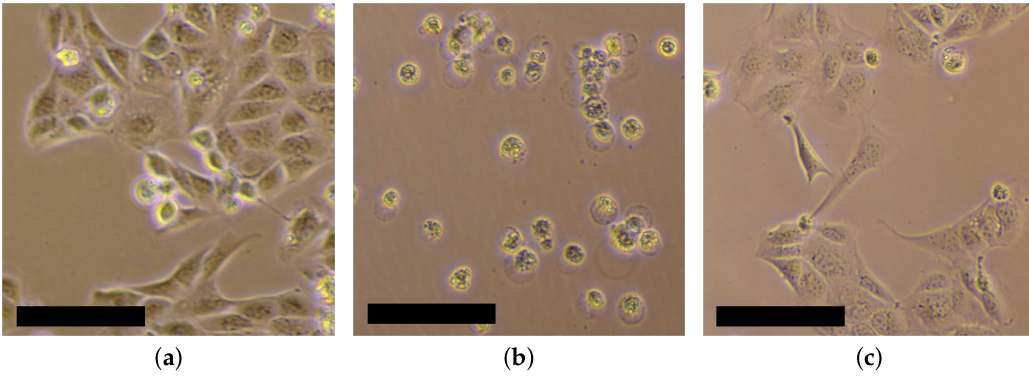
Figure 7. Culture of MDCK-cells with GMEM-medium 24h after seeding: ( a ) negative sample without any 3D-printed parts showing high cell viability; ( b ) cell culture in which a 3D-printed part out of HTM140 is inserted showing influence of the toxicity of the material; ( c ) cell culture with a 3D-printed part out of HTM140 that is coated with 10µm Parylene C showing the same cell viability as the negative sample. Scale bar is